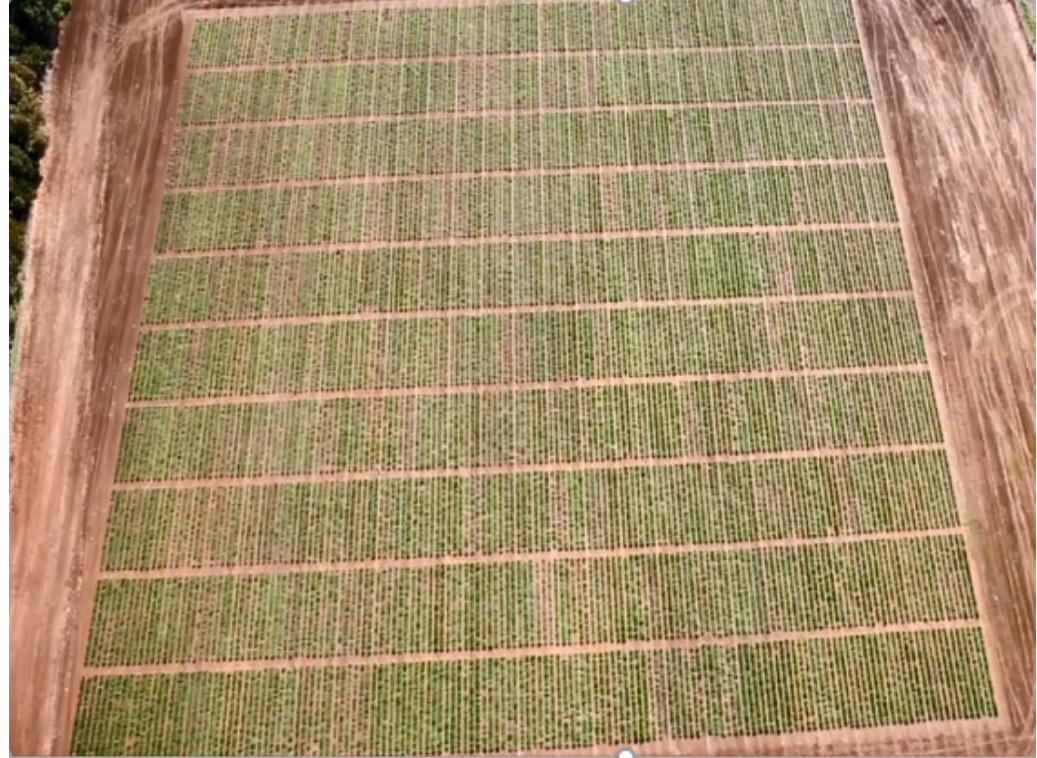
Figure 1. An aerial image of perennial ryegrass genomic subsection field trial which comprises 48,000 individual plants at Hamilton Centre, Victoria, Australia.